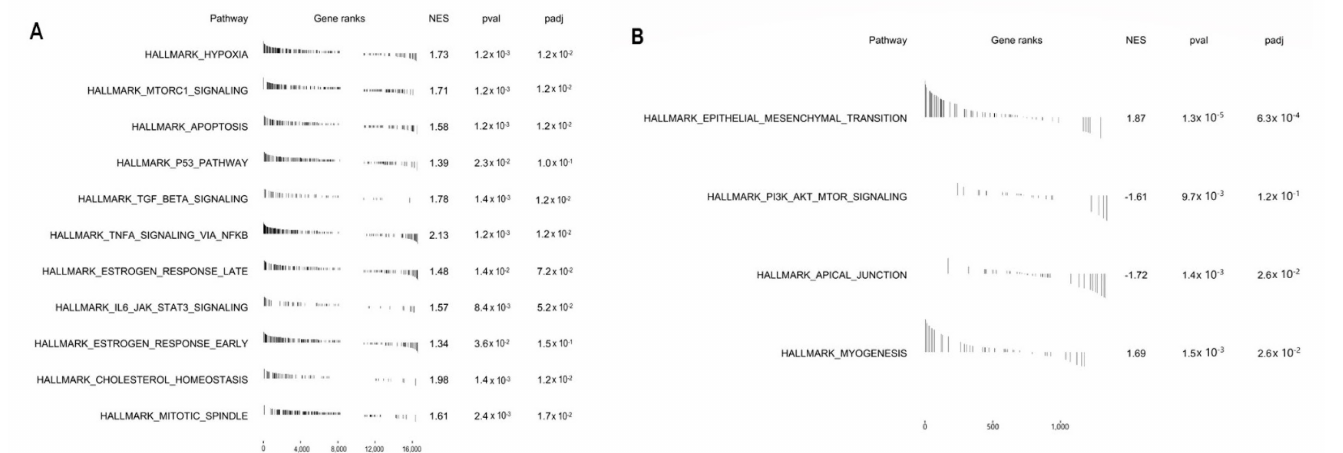
Figure 4. Enriched hallmark pathways identified by pre-ranked gene/protein set of the transcriptome ( A ) and the proteome data ( B ). The horizontal axis represents the gene set rank according to their enrichment scores. NES (normalized enrichment scores) with positive or negative signs indicate the direction of the enrichment pathway, that is, up-regulated or down-regulated